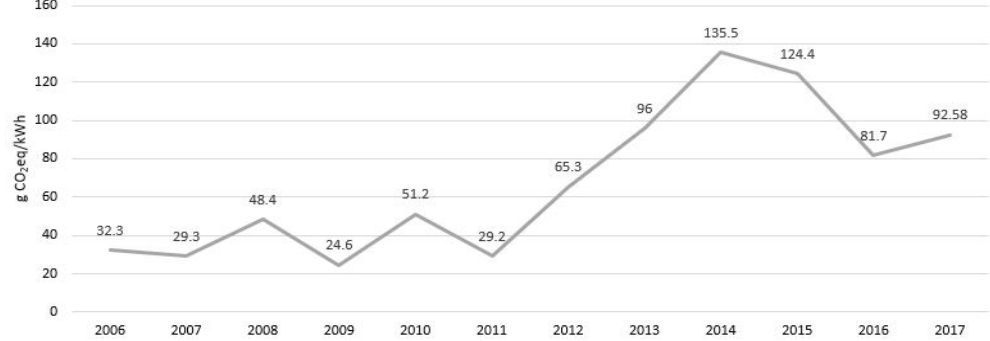
Figure 6. Evolution of Brazilian electricity emission factors in g CO 2 /kWh (2006–2017). Data were sourced from Reference [23].